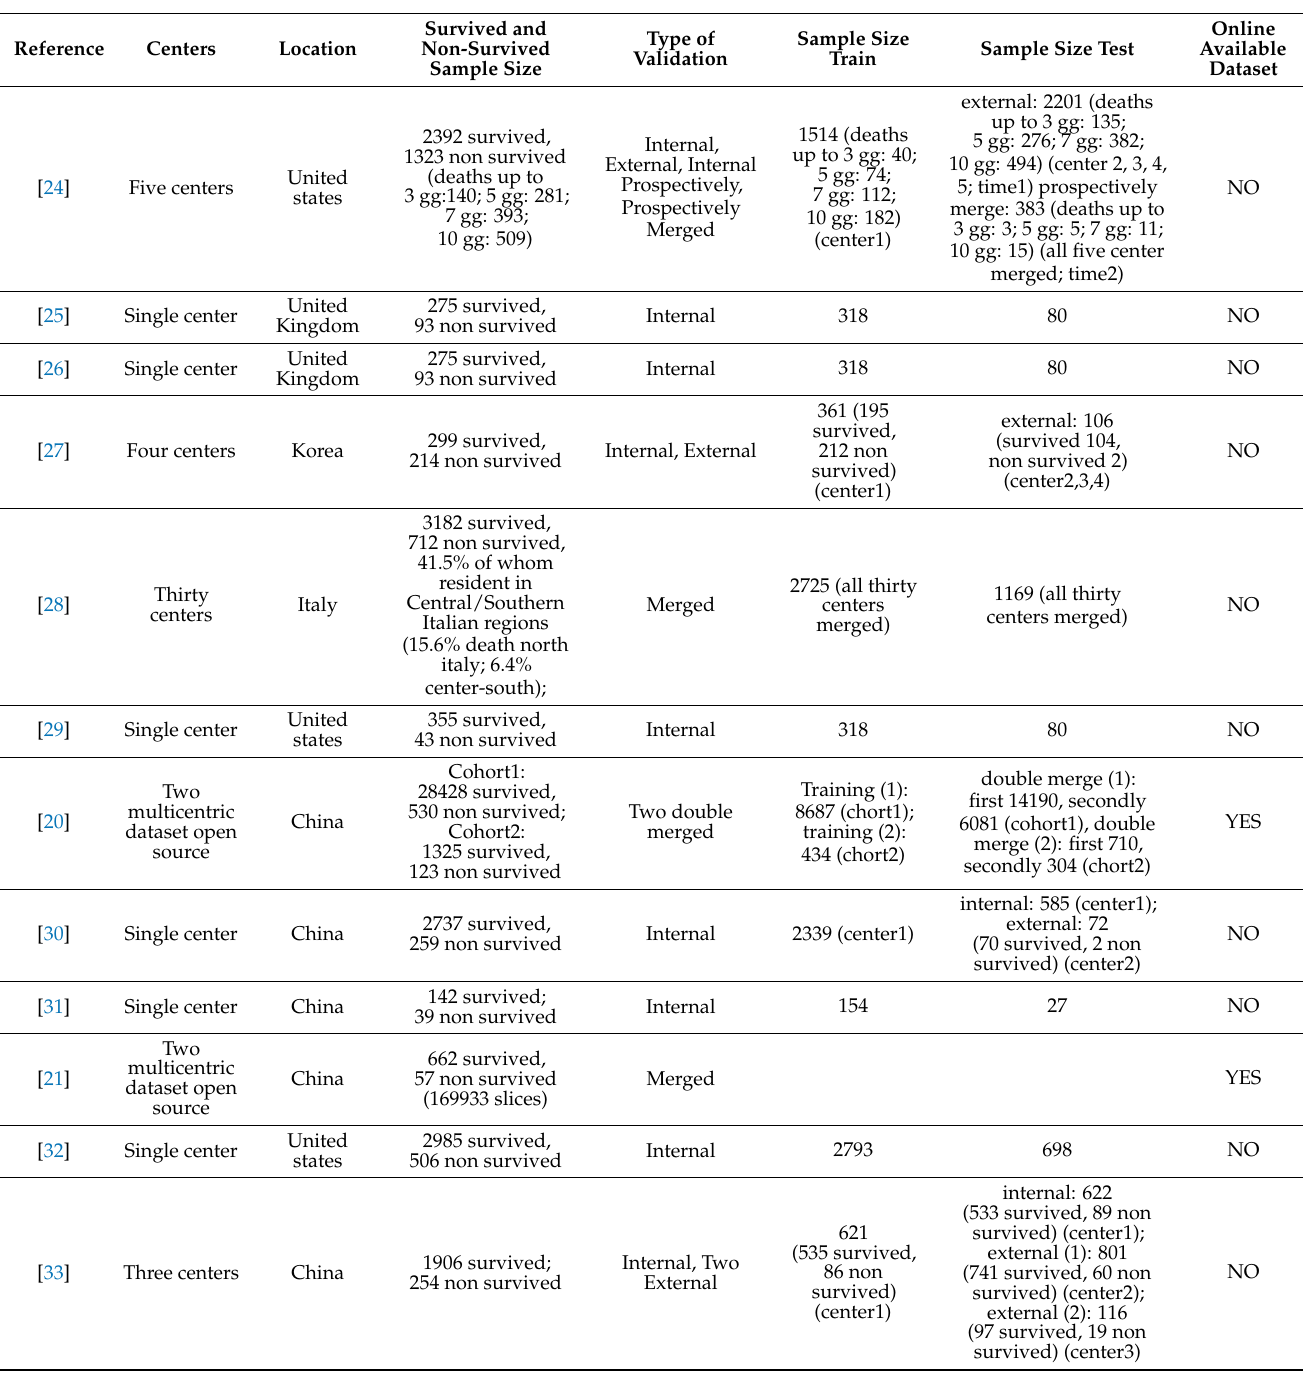
Table 1. Studies Data Sources, Samples and Validation